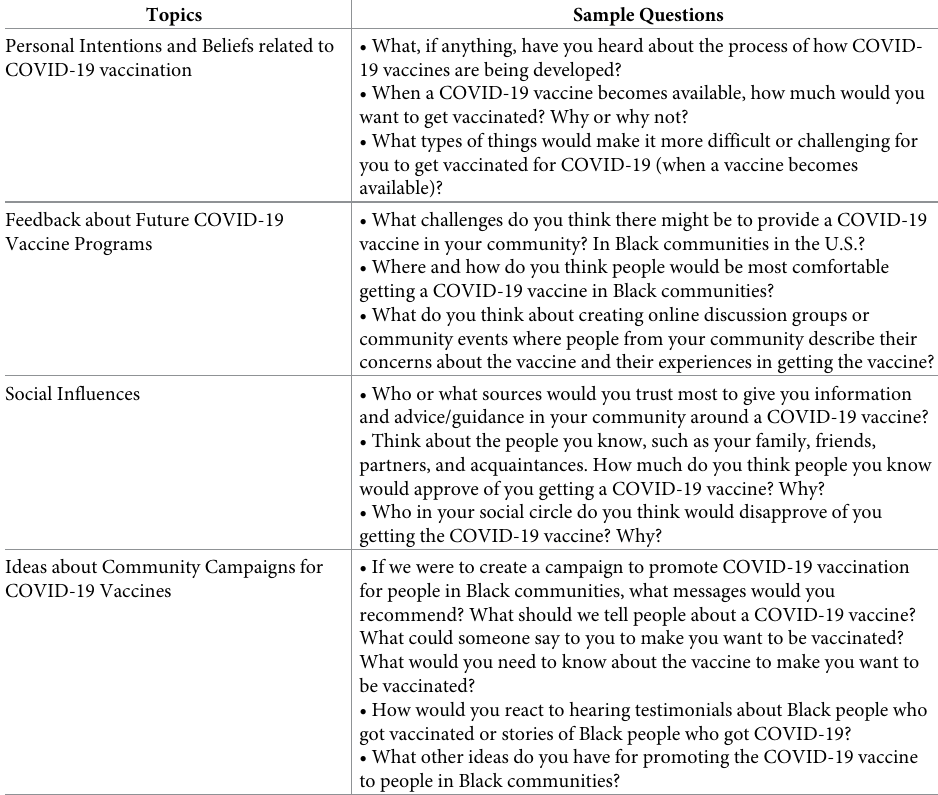
Table 1. Sample interview questions by